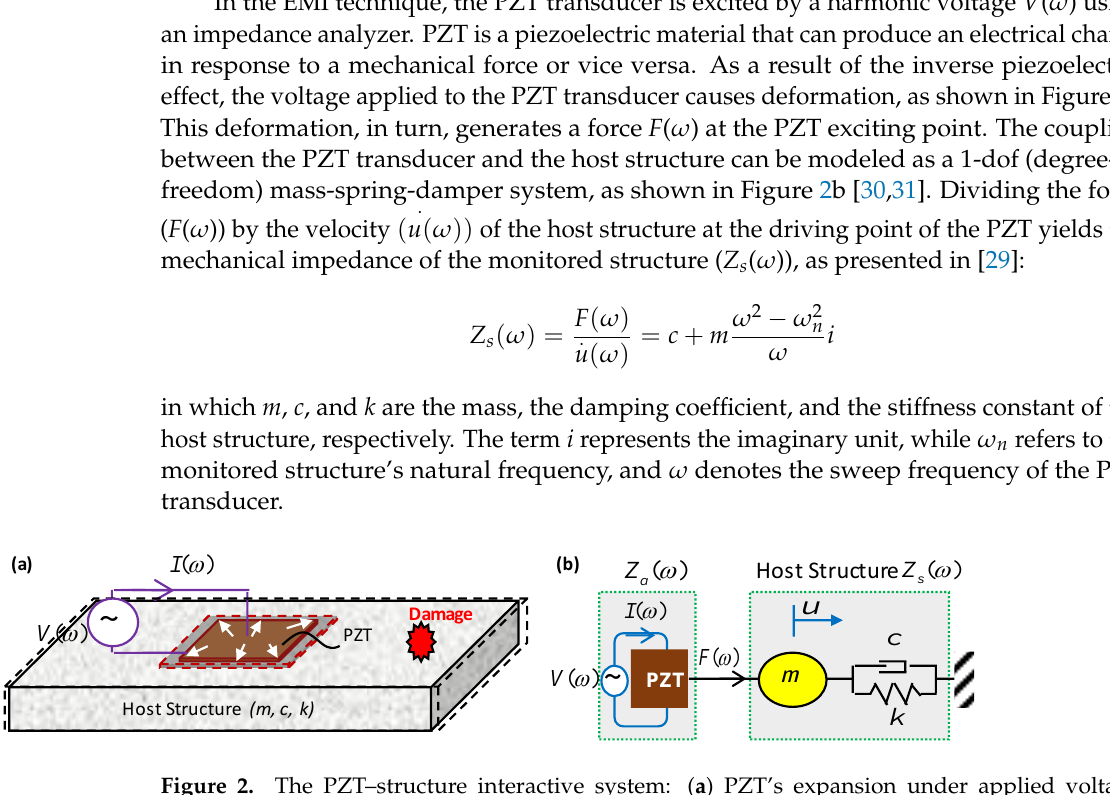
Figure 2. The PZT–structure interactive system: ( a ) PZT’s expansion under applied voltage; ( b ) simplified impedance model.